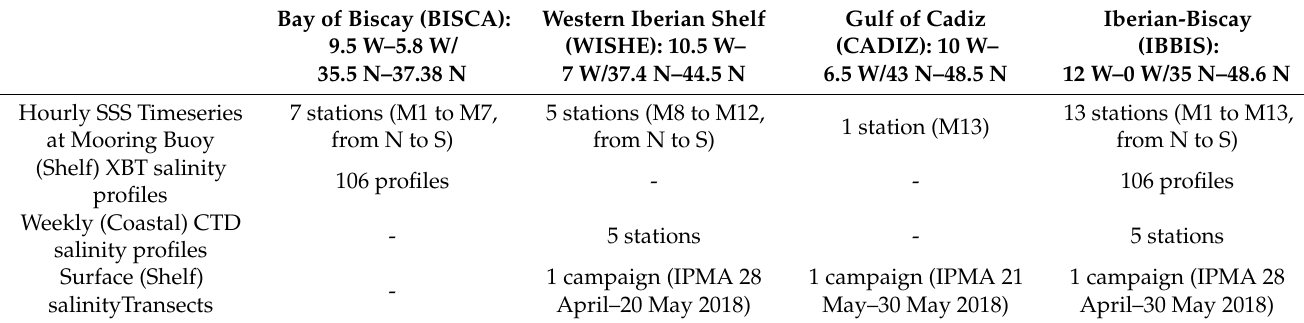
Table 1. Overview of the in-situ observational salinity data sources in the study domain and subregions. Bay of Biscay